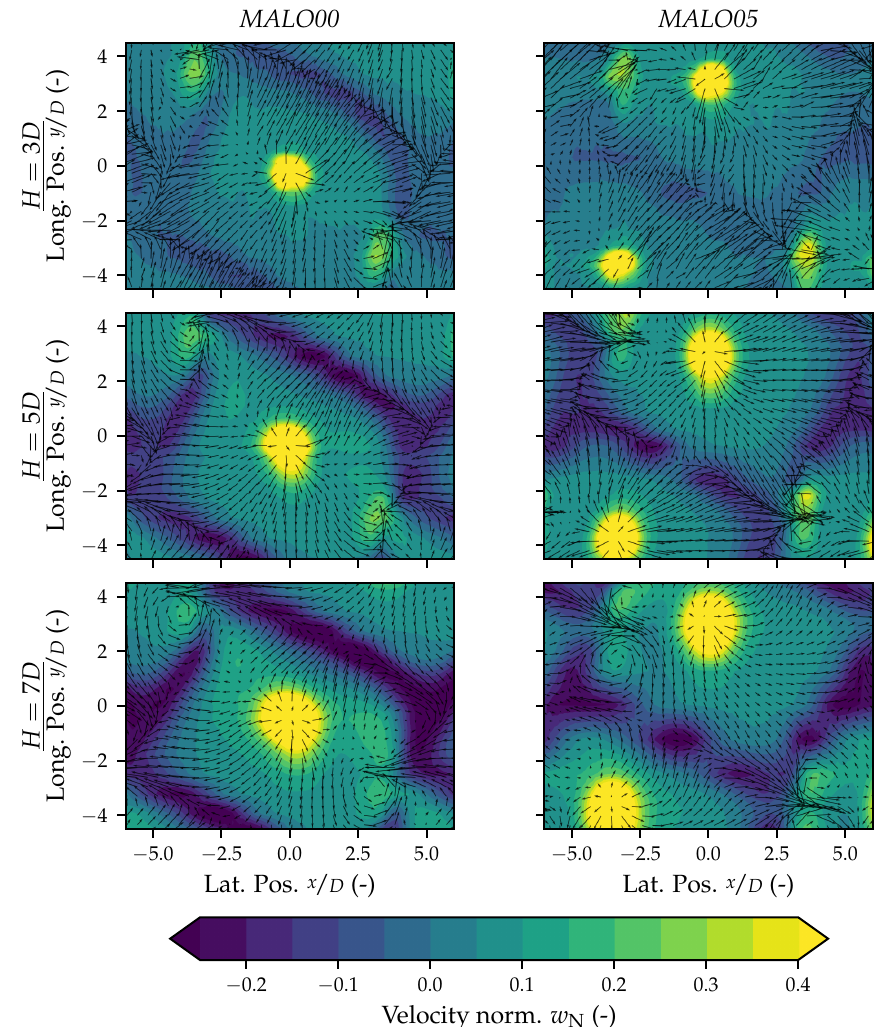
Figure A2. Cavity flow, low Reynolds number Re D ≈ 17 × 10 3 . w -velocity normalized shown at z -normal plane with H ∗ = 80%. Vectors show planar velocity components, unit length vec ul = 3. Rows show cavity height, columns show